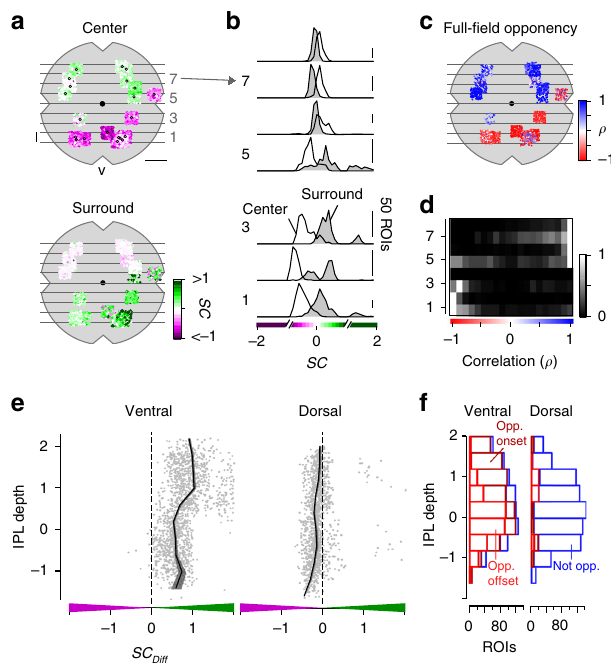
Fig. 4 Chromatic signals of bipolar cells match cone responses across the retina. a Distribution of recorded inner plexiform layer (IPL) scan fi elds (black circles), with ROIs color-coded according to their center (top) and surround spectral contrast (SC; bottom). ROIs are scattered around scan fi eld center by ±300 µ m in x and y. Gray lines and numbers on the left indicate bins used for analysis in b , d . Bin size: 0.5 mm, scale bar: 1 mm. b Distribution of center (no fi ll) and surround (gray fi ll) SC values from ventral to dorsal retina. Numbers indicate bins shown in a . For all bins, center SC was signi fi cantly different from surround SC (Linear mixed- effects model for partially paired data; see Methods and Supplementary Methods). c Same as a , but color-coded according to full- fi eld opponency (min( ρ onset , ρ offset ); Methods). d Peak-normalized histograms showing distribution of correlation coef fi cients of onset and offset full- fi eld events from ventral to dorsal retina. Numbers indicate bins shown in a . Bin size: 0.5 mm. e Difference of center and surround SC (SC Diff ) across the IPL for ROIs located in the ventral (left) and dorsal (right) retina. SC Diff signi fi cantly varied with IPL depth for both ventral and dorsal retina (Generalized additive model; see Methods and Supplementary Methods). f Distribution of onset (dark red; ρ onset < − 0.3 ) and offset (light red; ρ offset < − 0.3 ) full- fi eld opponent and non-opponent (blue) ROIs across the IPL for ventral and dorsal scan fi elds. Number of opponent ROIs signi fi cantly varied with IPL depth for ventral and dorsal retina (Generalized additive model; see Methods and Supplementary